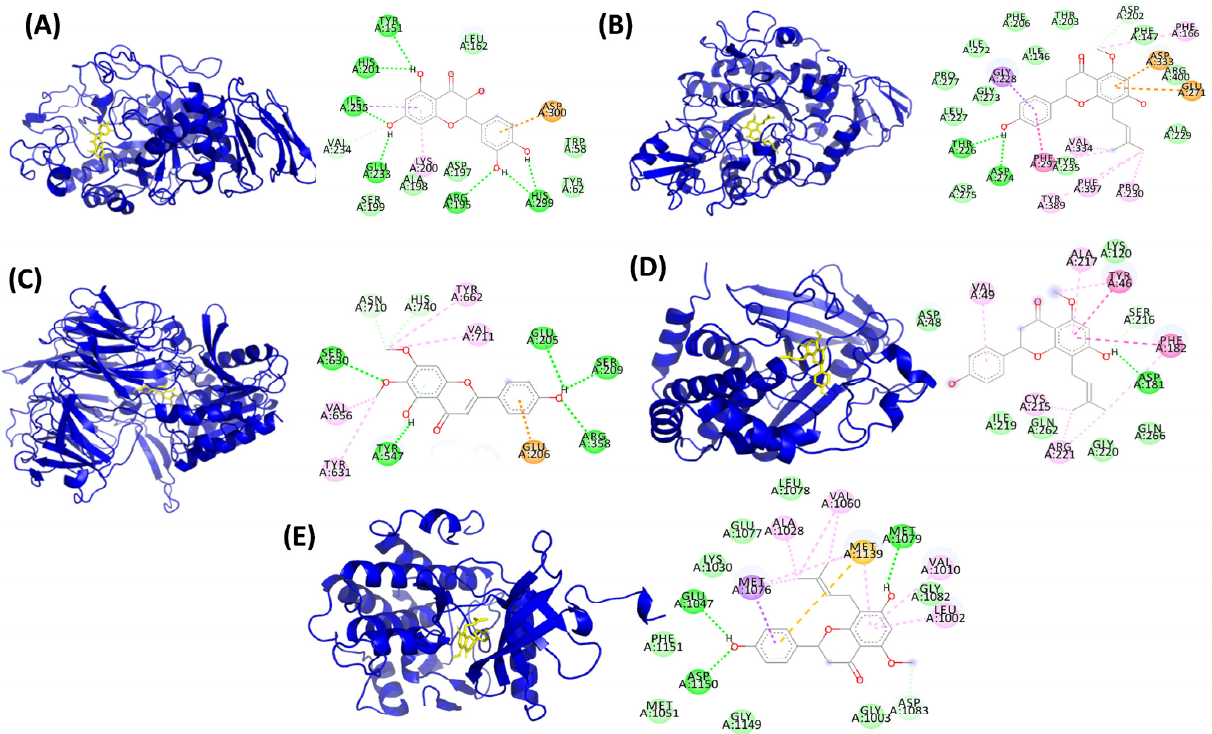
Figure 4. Binding pose and interactions of red rice phenolic metabolites (least binding energy) with target proteins involved in glucose regulation. ( A ) Dihydroquercetin & α -amylase, ( B ) Isoxanthohumol & α -glucosidase, ( C ) Cirsimaritin & DPPIV, ( D ) Isoxanthohumol & PTP1B, ( E ) Isoxanthohumol & insulin receptor substrate.